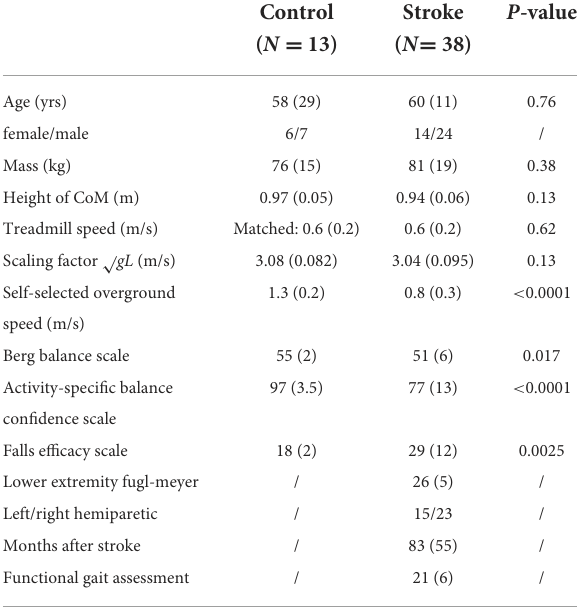
TABLE 1 Participant demographics for both control and stroke